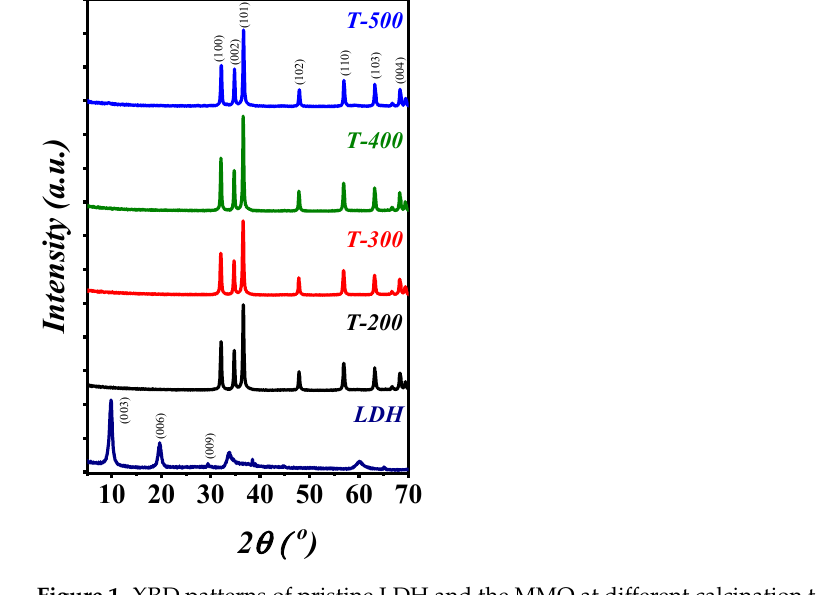
Figure 1. XRD patterns of pristine LDH and the MMO at different calcination temperatures.